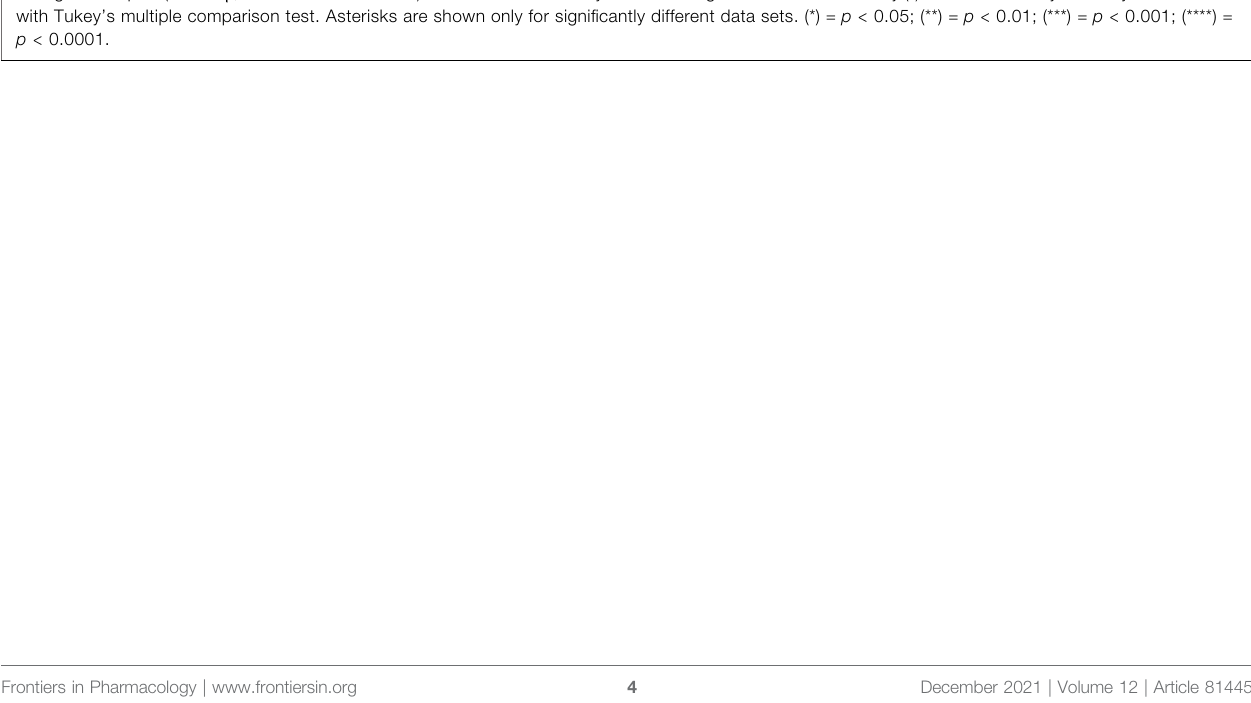
Frontiers in Pharmacology |